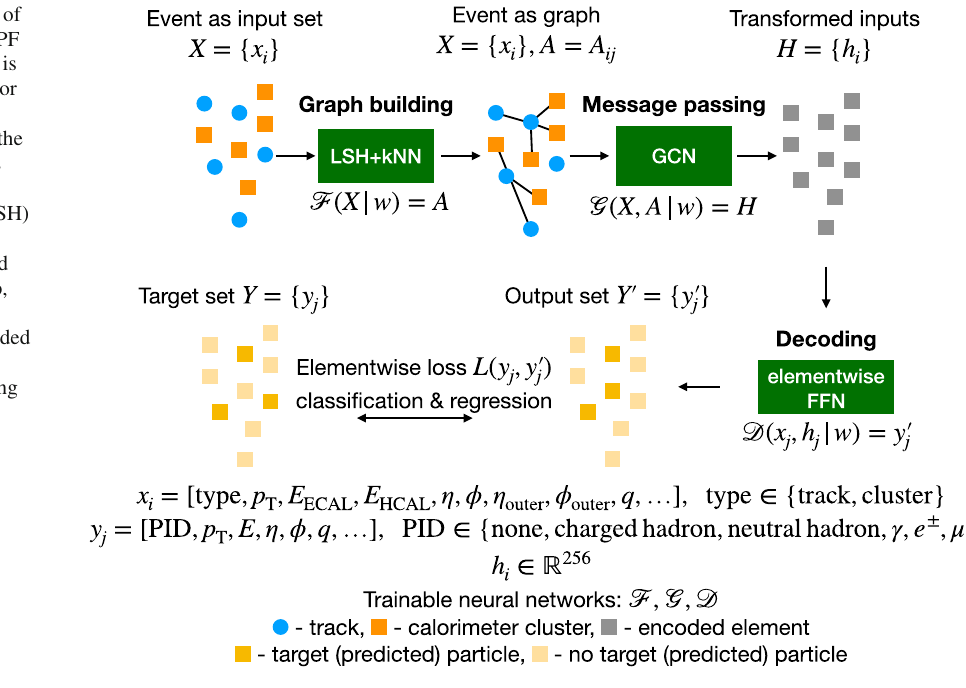
scalability (subquadratic time and memory scaling with the input size) are